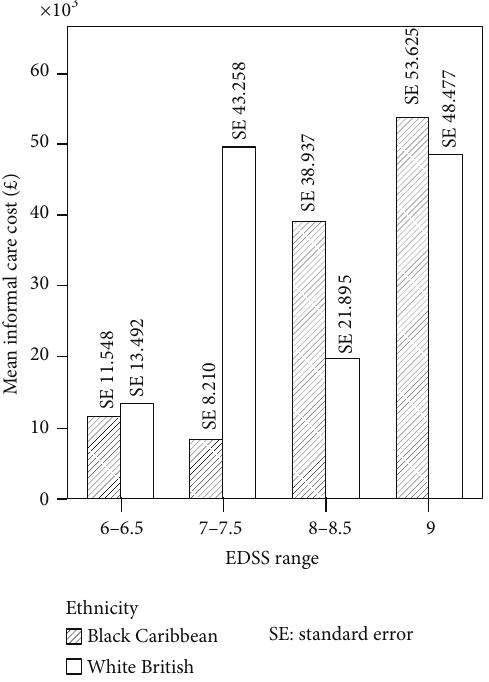
Figure 3: The mean formal care cost in each EDSS group for Black Caribbean and White British participants. Figure 4: The mean informal care cost in each EDSS group for Black Caribbean and White British participants.